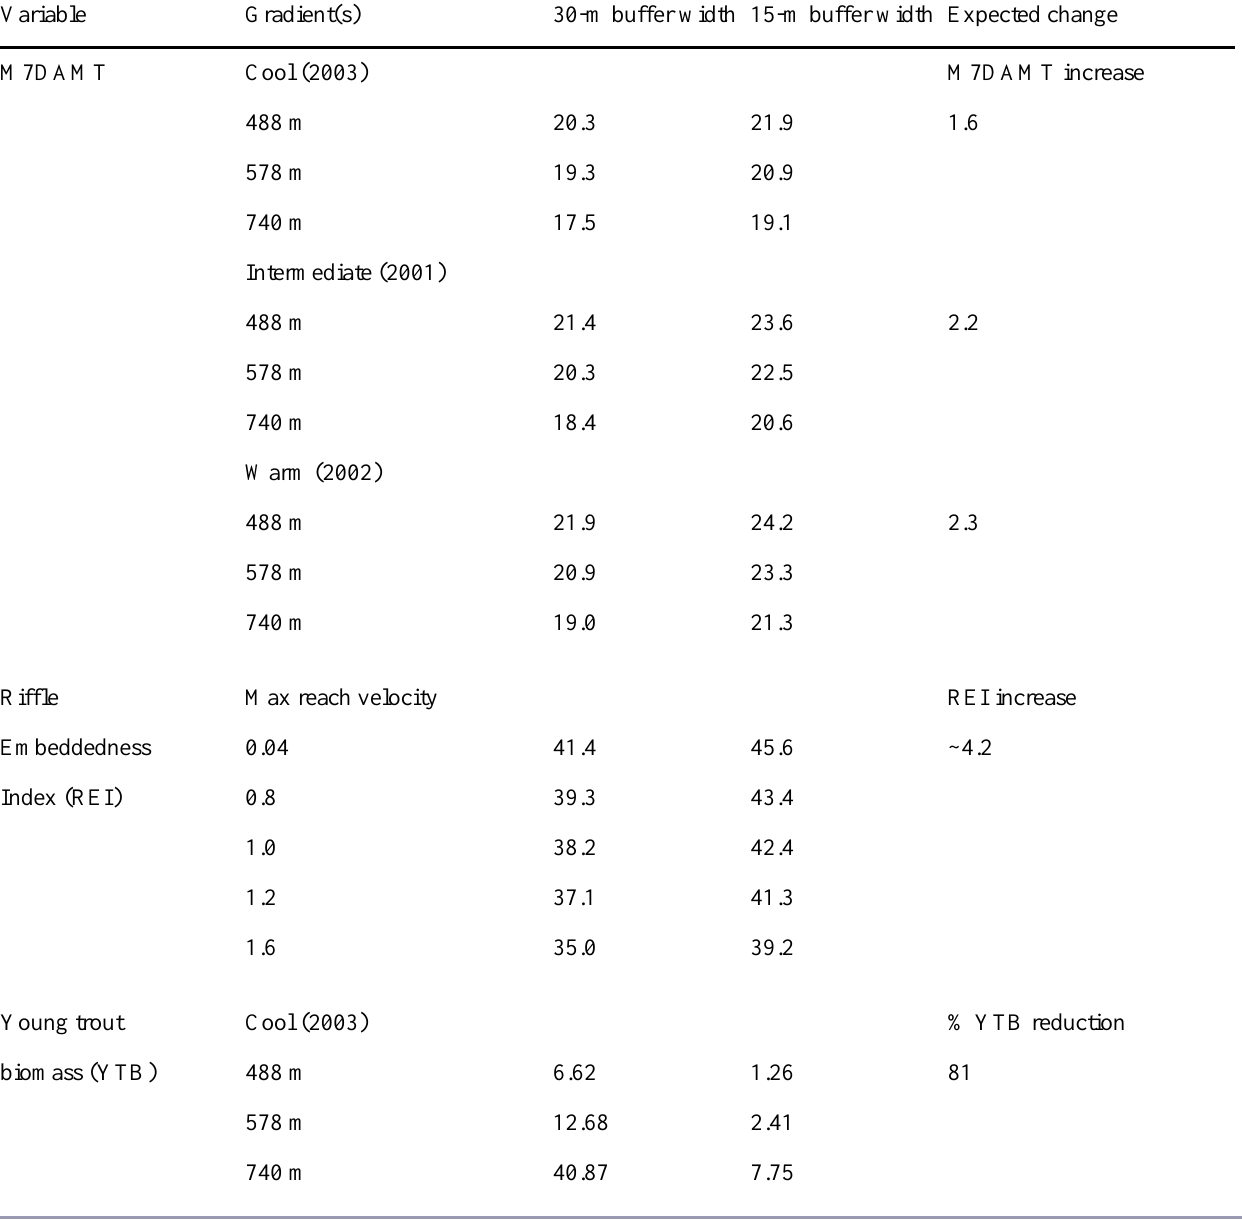
Table 6. Expected stream temperature (M7DAMT), riffle embeddedness conditions (REI), and young trout biomass (YTB) associated with 30- vs. 15-m average riparian buffer widths along the stream network above a given stream segment. M7DAMT and YTB were calculated for cool, intermediate, and warm summers using the three sets of regression coefficients derived for Eq. 3 and across the elevation range where young trout were observed. REI values were calculated for the range of maximum reach velocities where young trout were observed. YTB was calculated with the average maximum reach depth for sites with young trout (0.68